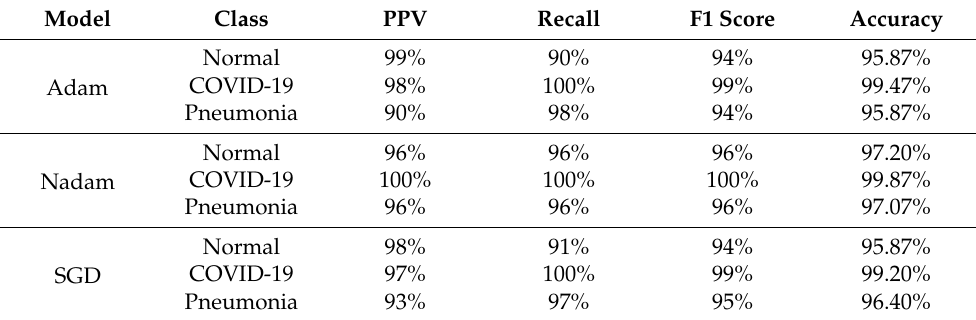
Table 13. Comparison of different optimizers for LDDNet for the case of the balanced X-ray